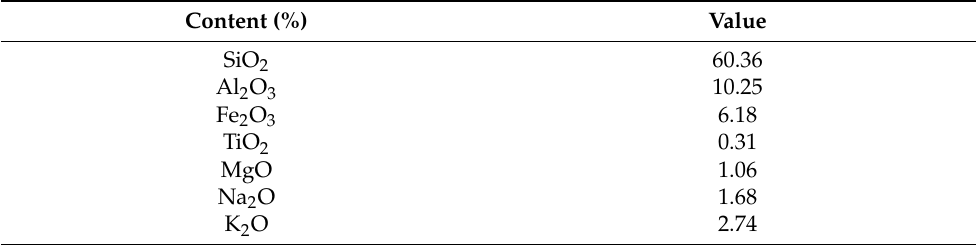
Table 2. Chemical composition of